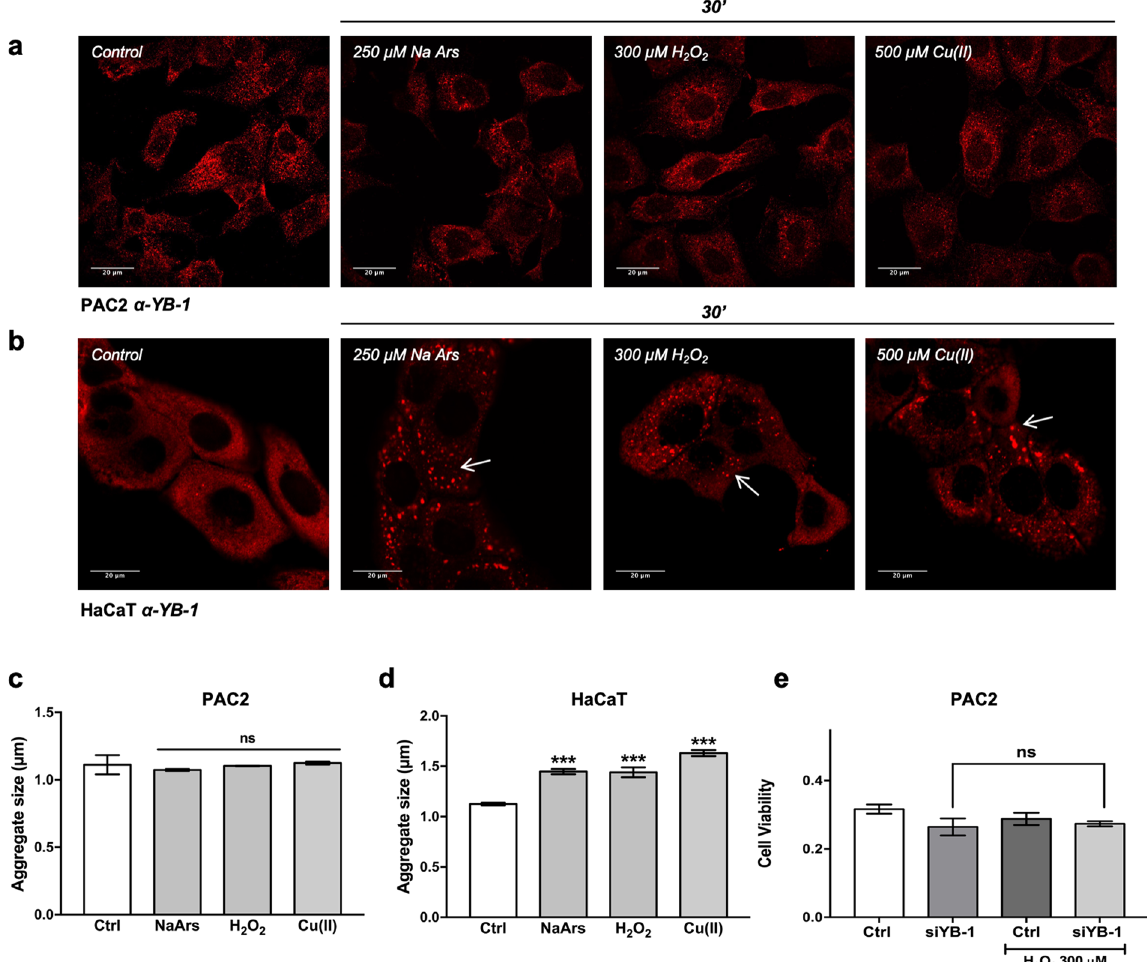
comparisons test (see also Table